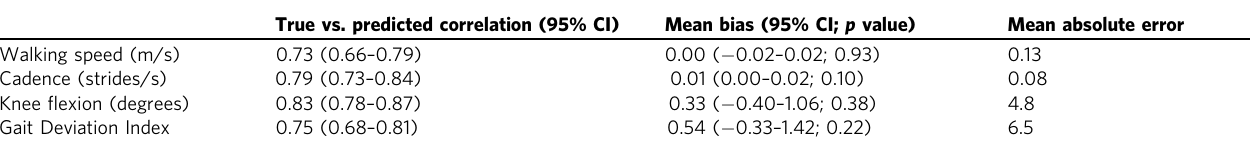
Table 1 Model accuracy in predicting continuous visit-level